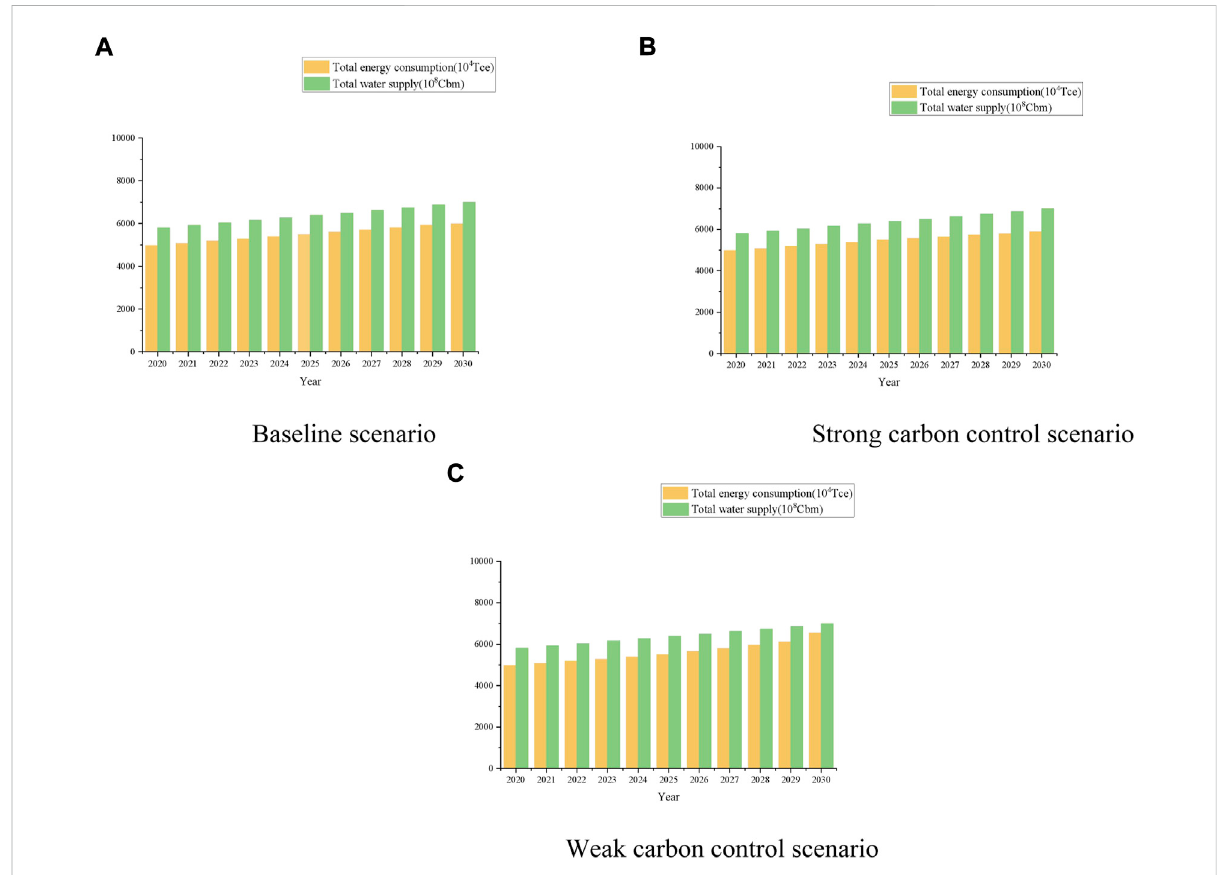
FIGURE 4 Forecastofenergyconsumption,andwatersupplyin2030, (A) Baselinescenario. (B) Strongcarboncontrolscenario. (C) Weakcarboncontrolscenario.